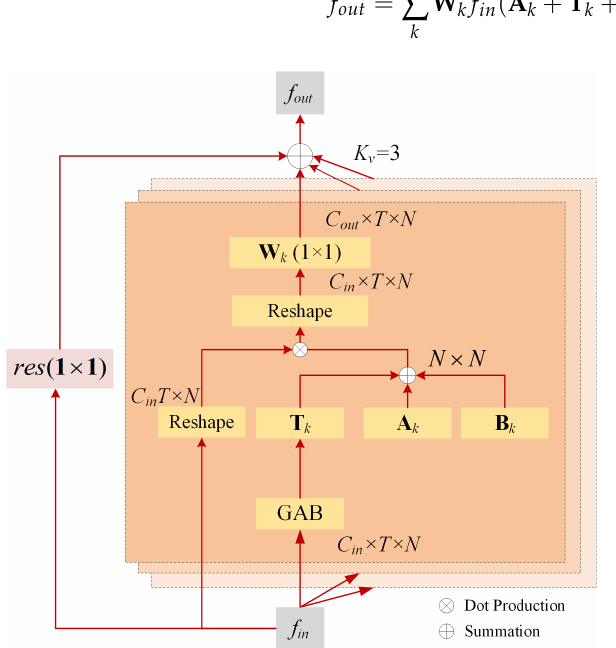
Figure 3. The calculation process of